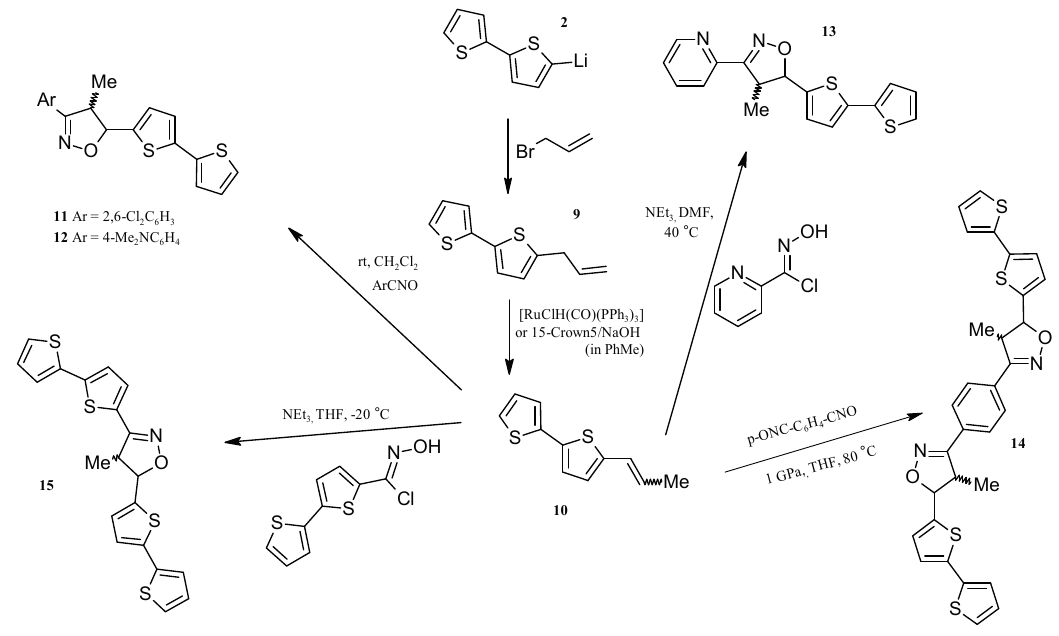
Scheme 5. Synthesis of isoxazolines ( E + Z )-( 10 ): cis + trans